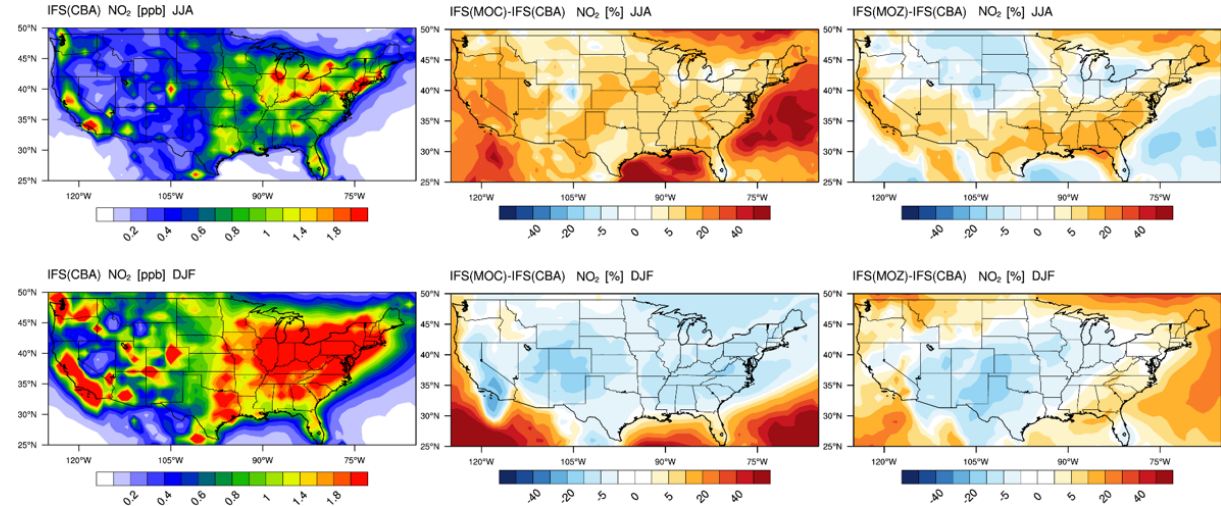
Figure 12. The horizontal mean cross section of NO 2 below 1km over the US domain for JJA 2014 (top) and DJF (2014/2015).